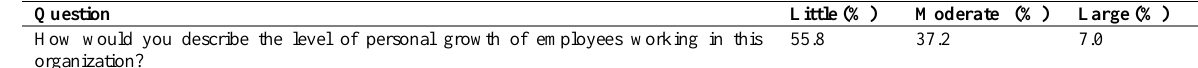
Table 4: Respondents Views of Career Advancement at